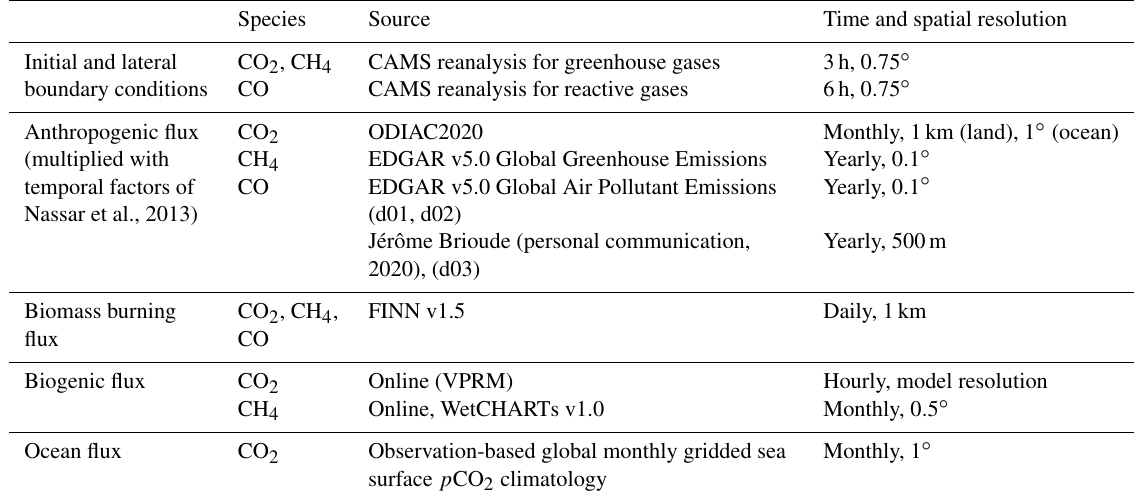
Table 1. Overview of data sets used as input for the WRF-GHG